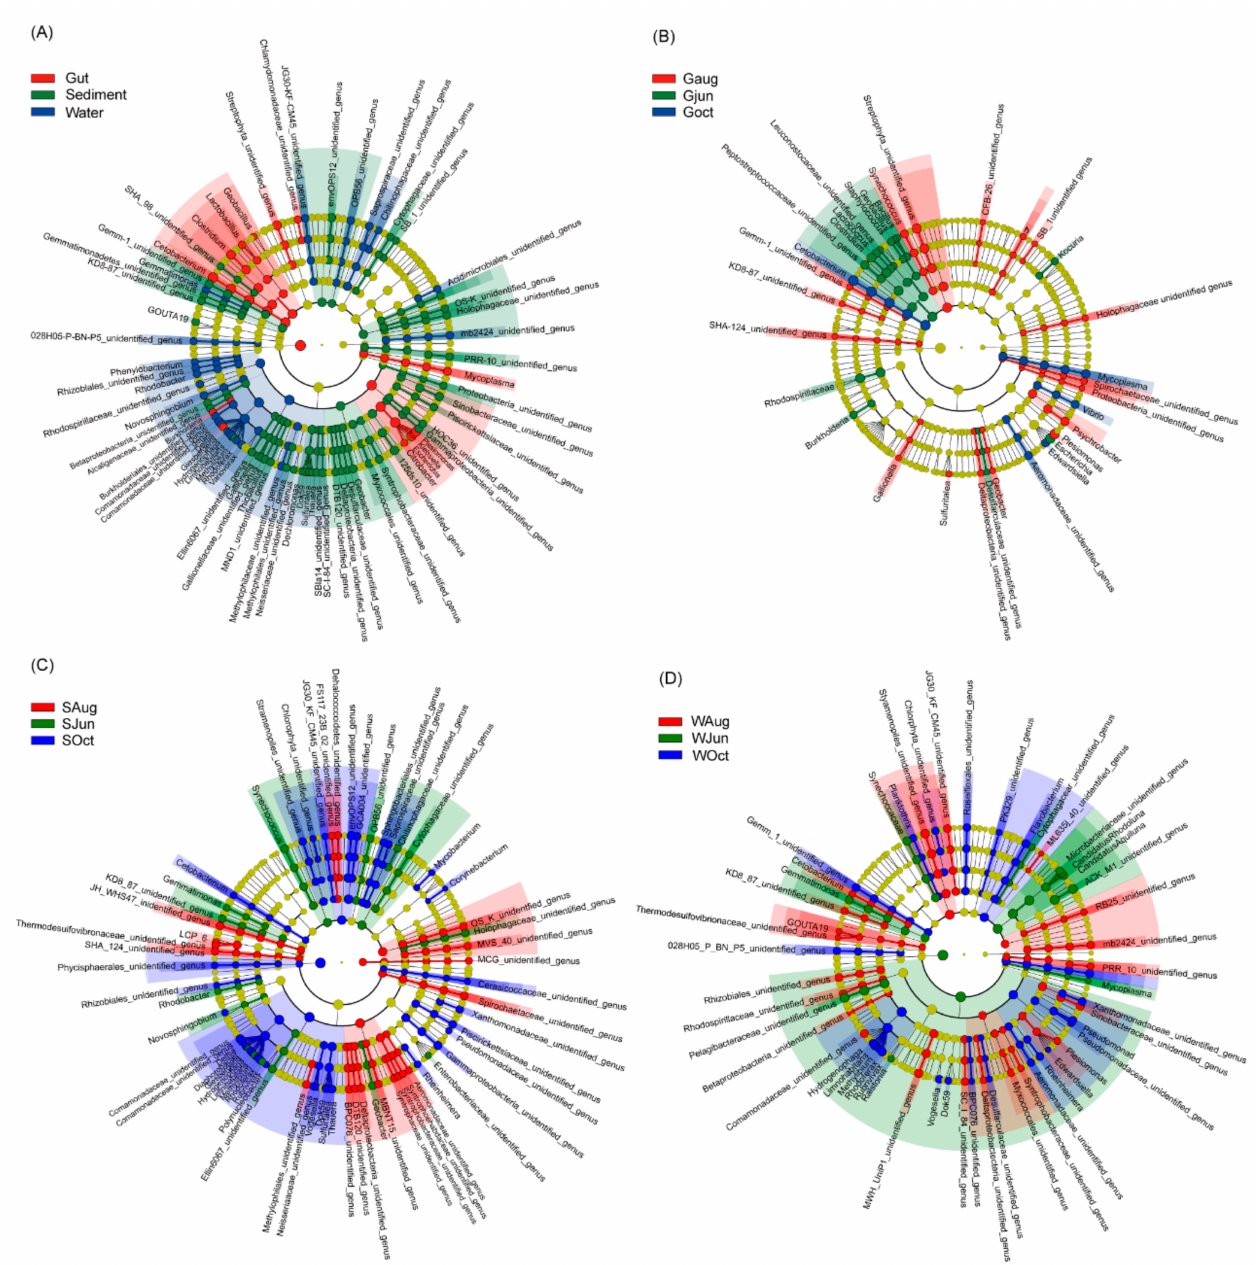
Figure 3. Cladogram plots illustrating significantly different genera ( A ) among different habitats and among different sampling times for microbiota analysis of ( B ) the gut of largemouth bass, ( C ) sediment, and ( D ) pond water. The results with LDA scores (log 10) > 2 were considered statistically